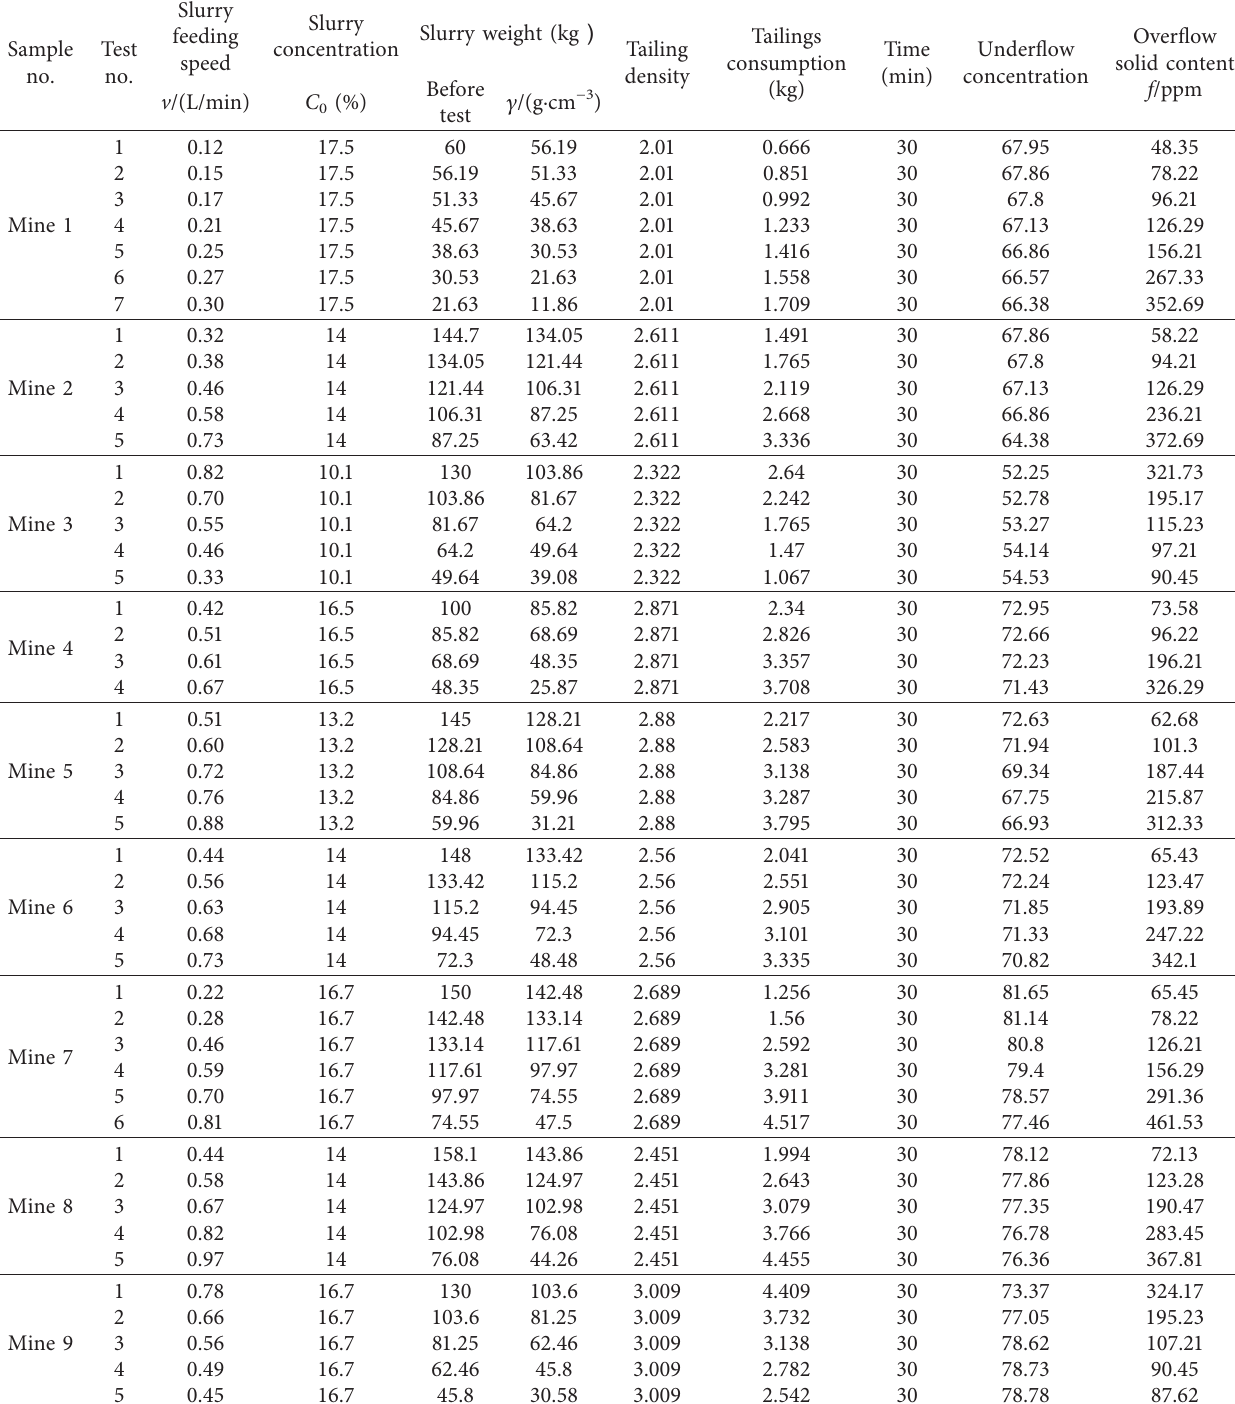
Table 2: Results of dynamic thickening